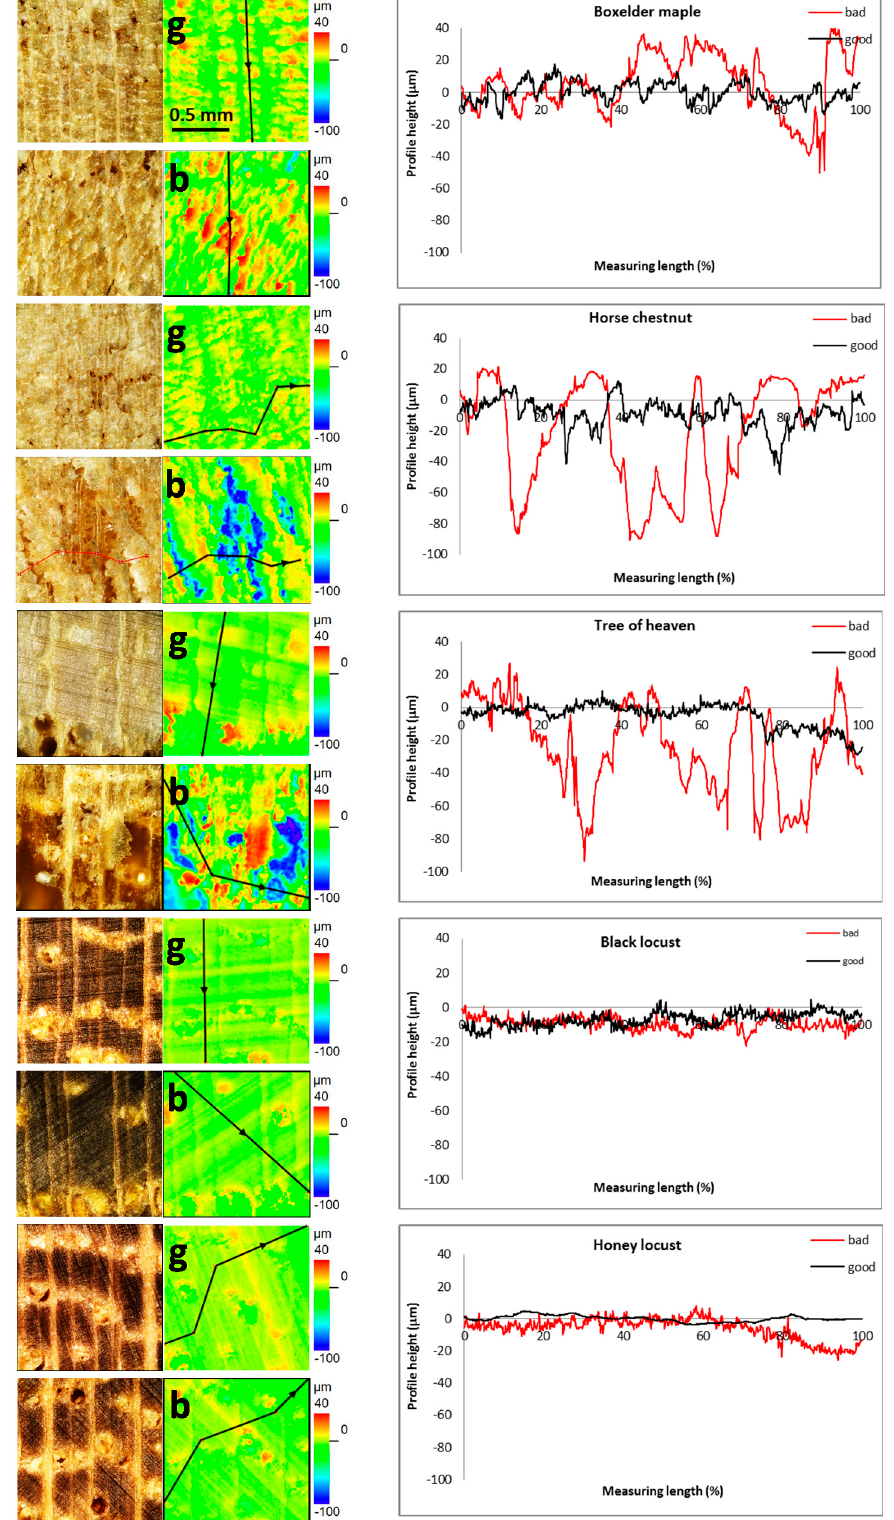
Figure 6. Areas and profile measurements done by a laser scanning microscopy of all analyzed species: g—good surface, b—bad surface. Black lines on area measurements designate the profile measurements.